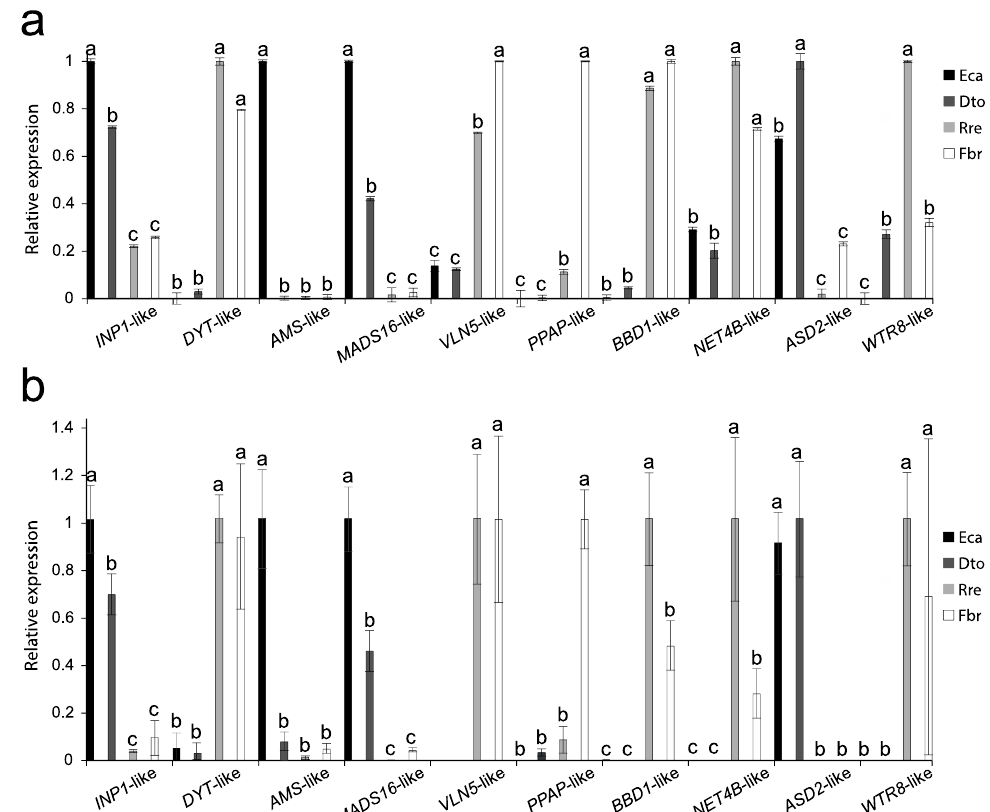
Figure 8. Results of RT-qPCR analysis to confirm the differential expression found by RNA-seq of 10 transcripts among the different species studied. ( a ) Results of RT-qPCR. Values on the y-axis represent the relative expression intensities found using the 2 ΔΔCt method. ( b ) Results of RNA-seq. Values on the y-axis represent the relative expression levels, quantified using StringTie coverage values. In ( a , b ) for each gene, the expression levels were compared among the homologues of the four species analysed, taking the homologue with maximum expression as reference (arbitrary value = 1). Different letters above the bars within each species indicate statistically significant differences in gene expression according to Tukey’s test ( p < 0.05). INP1 -like, INAPERTURATE POLLEN